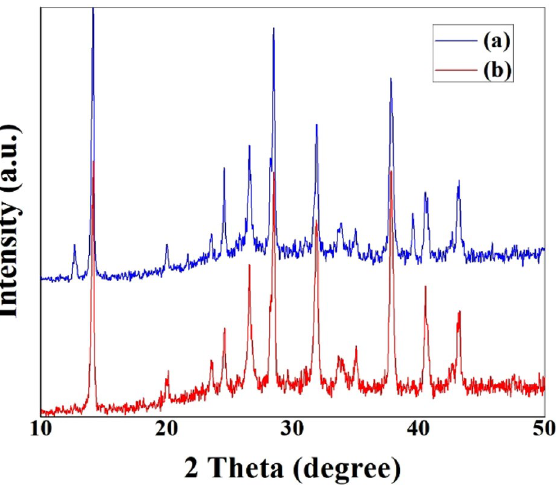
Figure 2. XRD patterns of ( a ) FTO/SnO 2 @ZnO nanocomposite/perovskite, and ( b ) FTO/SnO 2 @ZnO.PANI